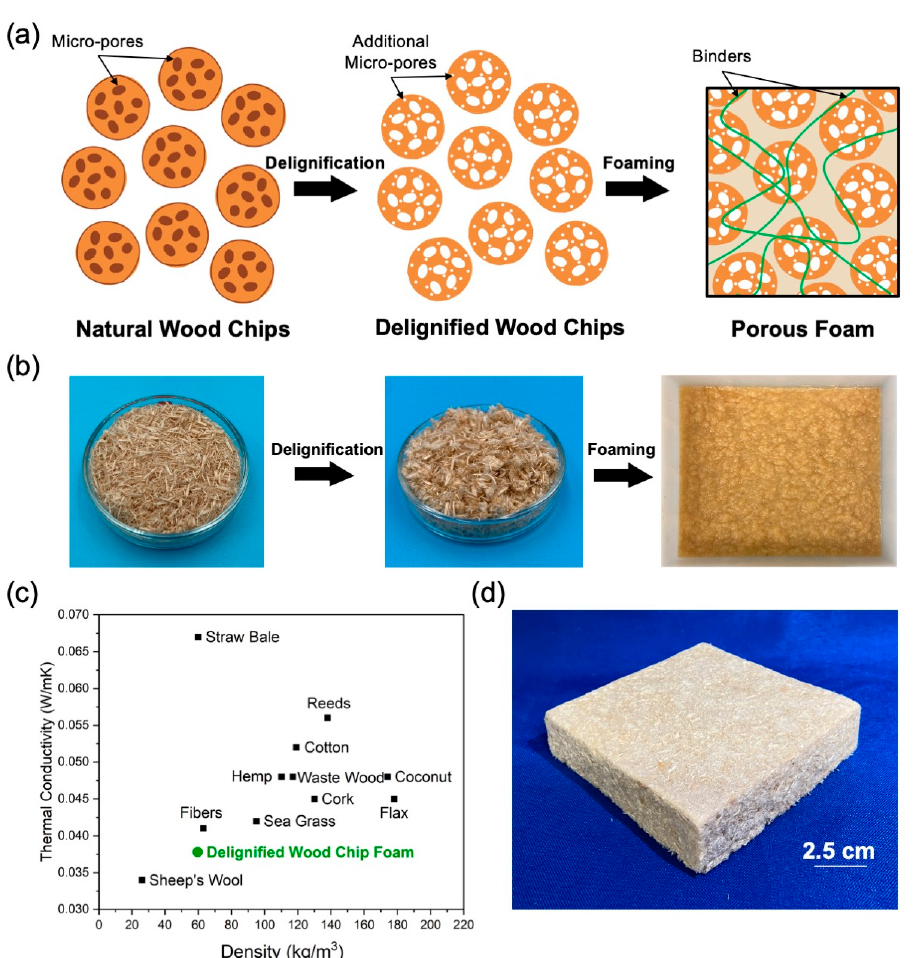
Figure 1. Fabrication process. ( a ) Detailed schematic and ( b ) photographs of the foaming fabrication process. ( c ) Thermal conductivity comparison of various bio-based thermal insulation materials. ( d ) Newly fabricated porous foam from delignified poplar wood chips.